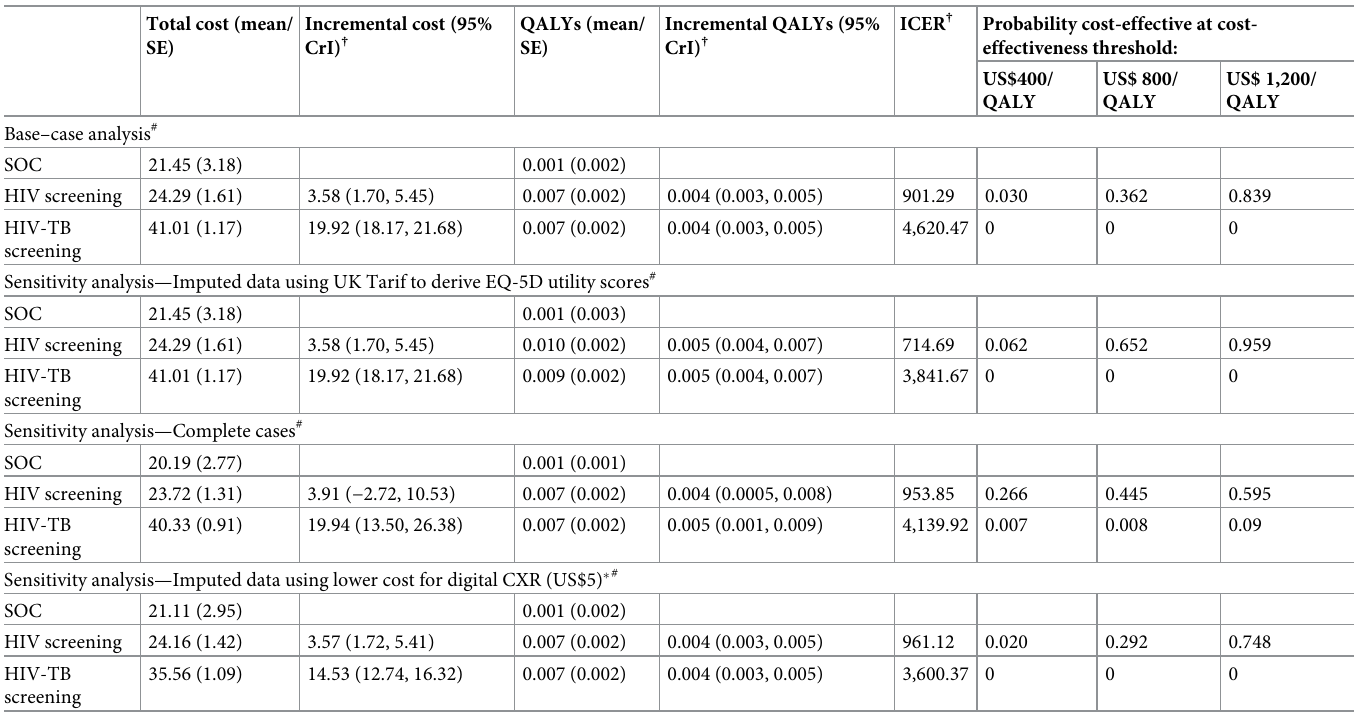
Table 3. Health-related quality of life outcomes by treatment